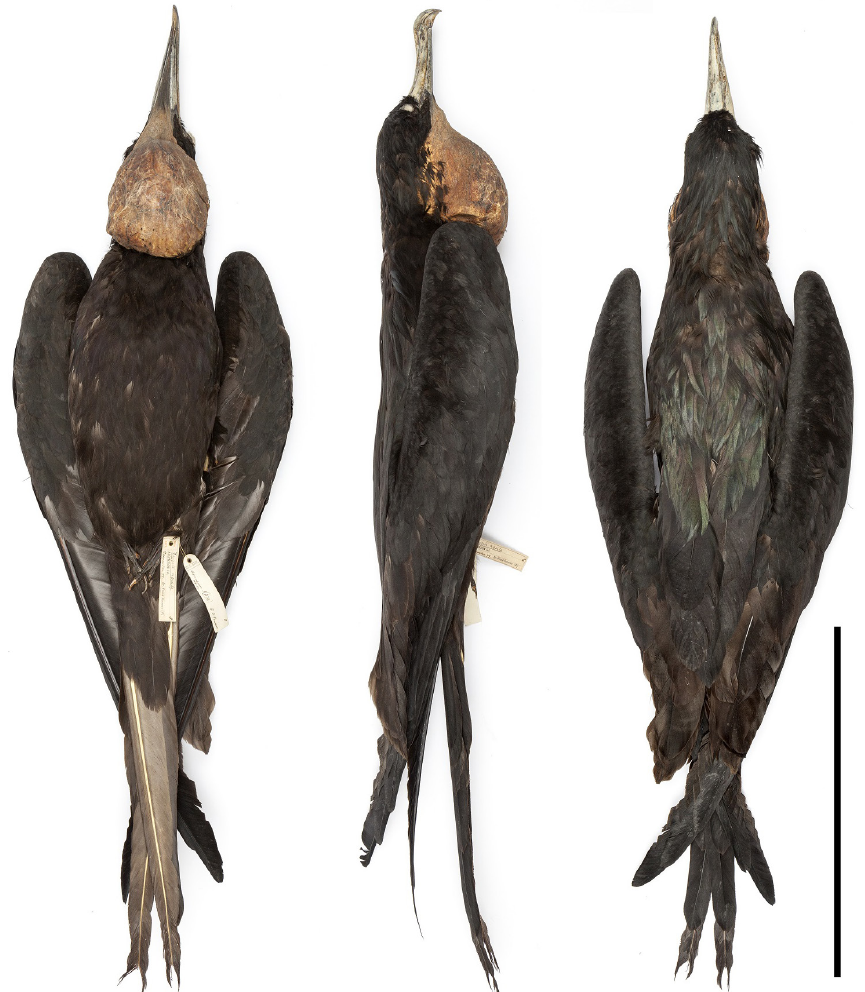
Figure 3. Neotype of Fregata aquila (Linnaeus, 1758): Ventral, lateral, and dorsal views of specimen BMNH 1899.1.4.13 in the Natural History Museum at Tring, UK. Scale bar: 30